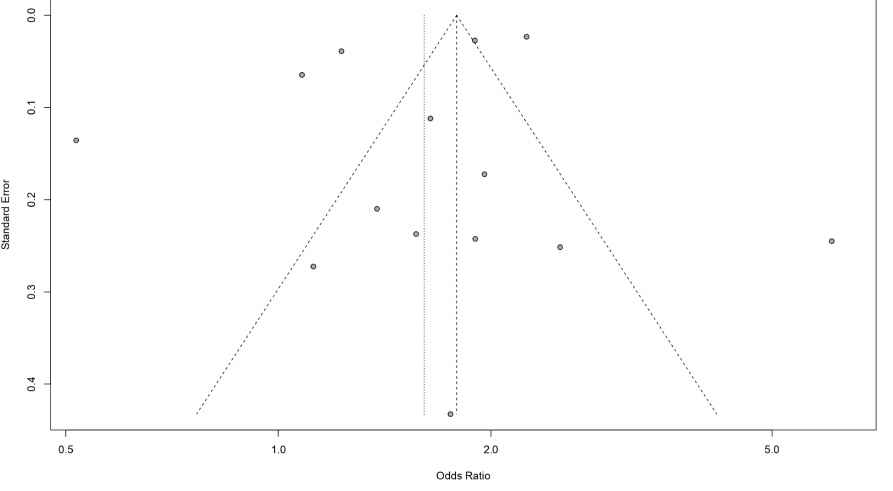
Figure 8. Funnel plot for the publication